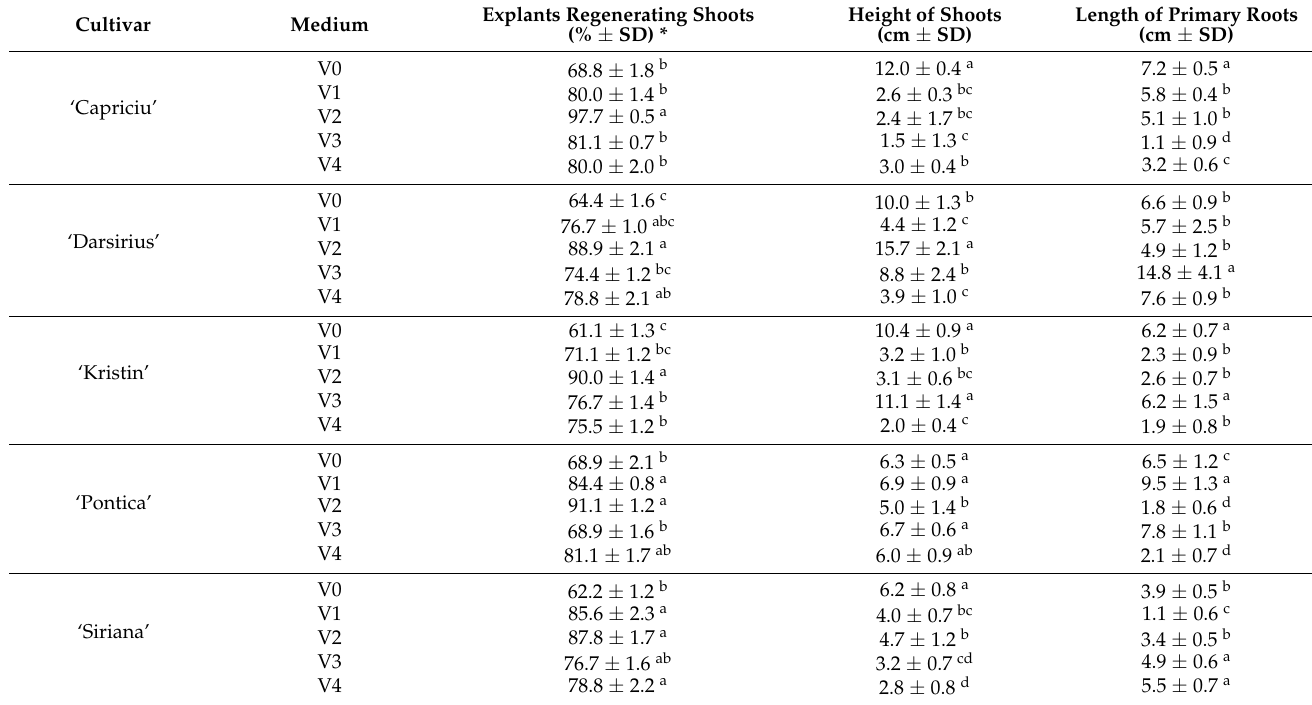
Table 4. Direct shoot organogenesis from apical buds on culture media with different